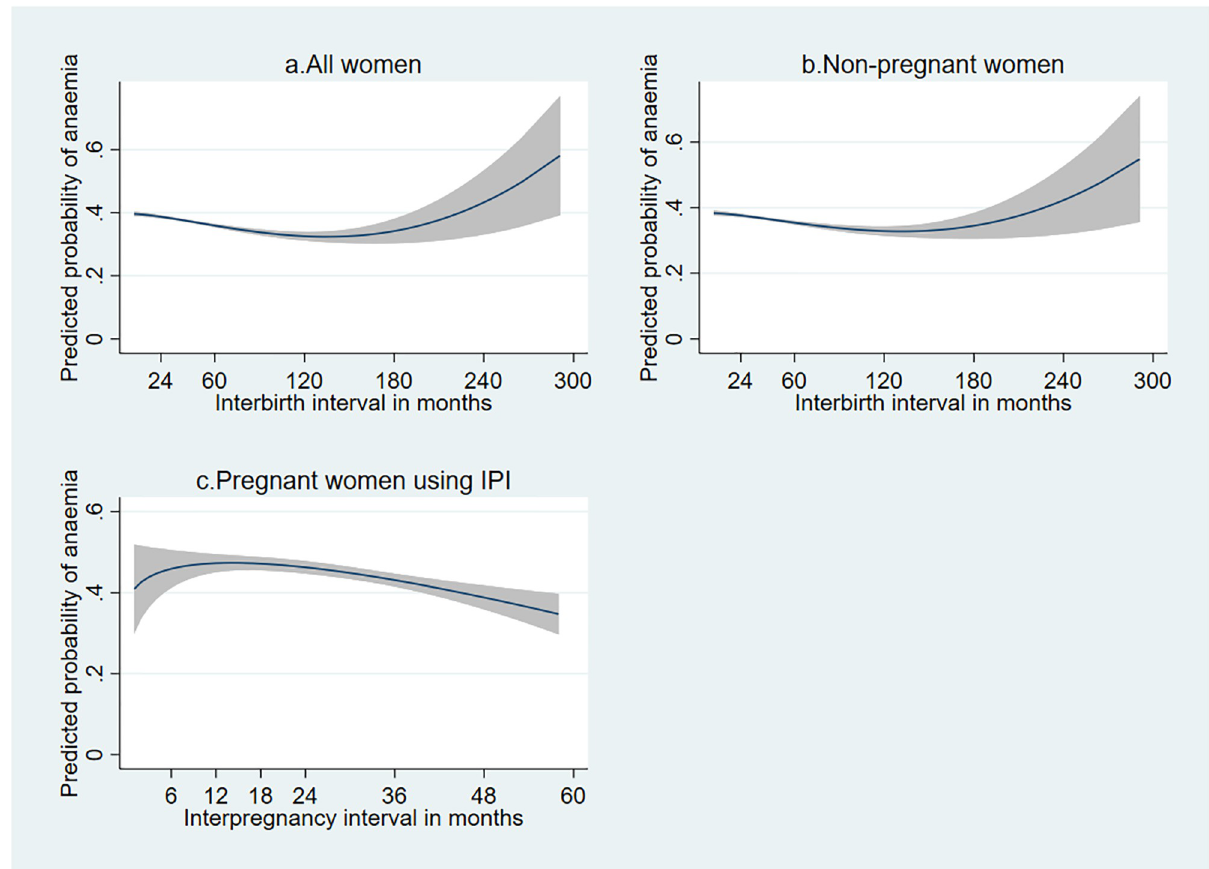
Fig 2. The association between interbirth interval and predicted maternal anaemia based on the first-degree fractional polynomial.